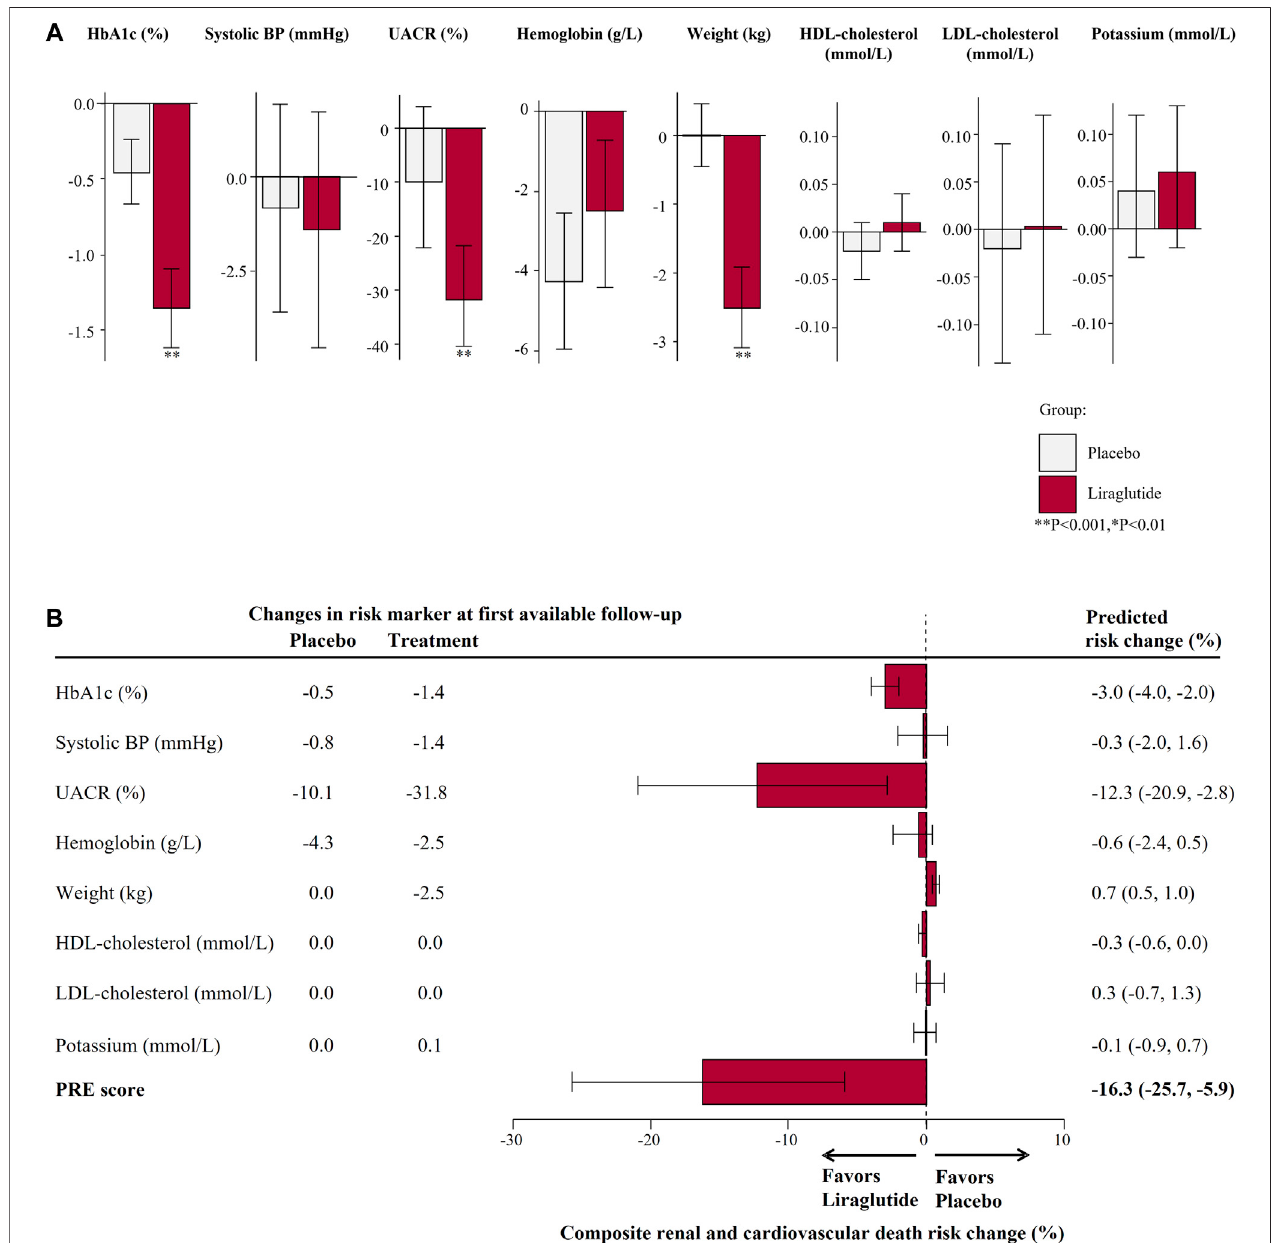
FIGURE3|(A) Meanchangesinriskmarkersfrombaselineto6-months(or fi rstfollow-up)measurementinthesubsetoftheLEADERTrialaccordingtotheFLOW trial inclusion criteria (N = 327). Changes are presented as mean with 95% con fi dence intervals, for the placebo and liraglutide group. (B) Predicted risk change for the primarycompositekidneyorcardiovasculardeathoutcomesfortheongoingFLOWtrialbasedonsingleriskmarkerchangesaswellasthePREscore.HbA1c,glycated hemoglobin; BP, blood pressure; UACR, urinary-albumin-creatinine-ratio; HDL, high-density-lipoprotein; LDL, low-density-lipoprotein; PRE score, Parameter Response Ef fi cacy